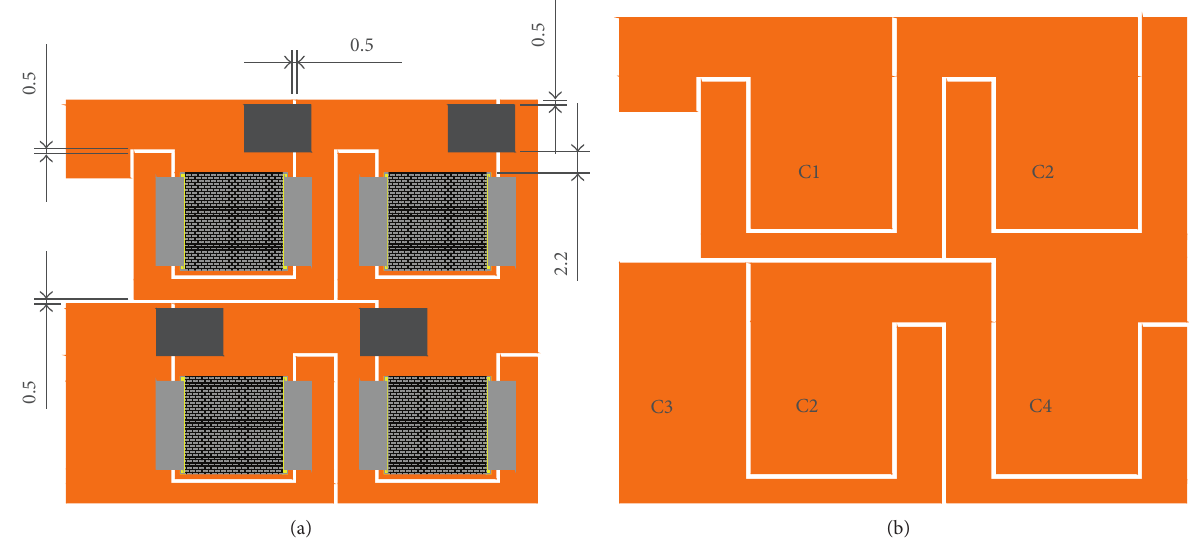
Figure 14: A four-cell V3.1 pattern. In (a), cells and diodes are reported with dimensions in mm. In (b) the copper shapes employed for the pattern are highlighted.